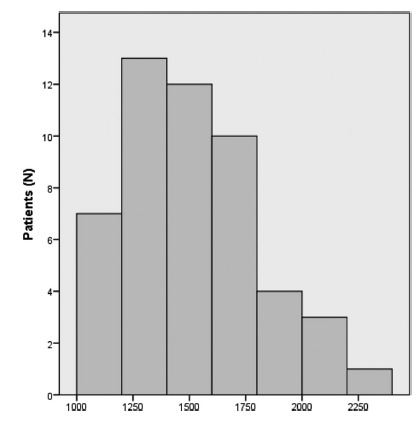
Pre-intervention resting energy expenditure: distribution as calculated by indirect calorimetry